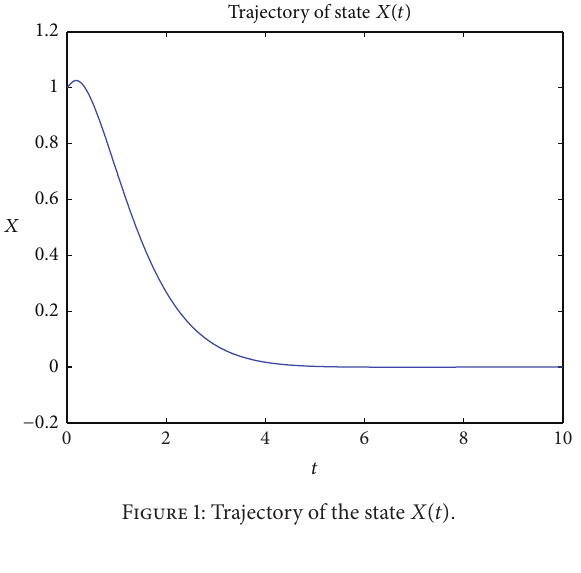
Figure 1: Trajectory of the state 𝑋(𝑡) .